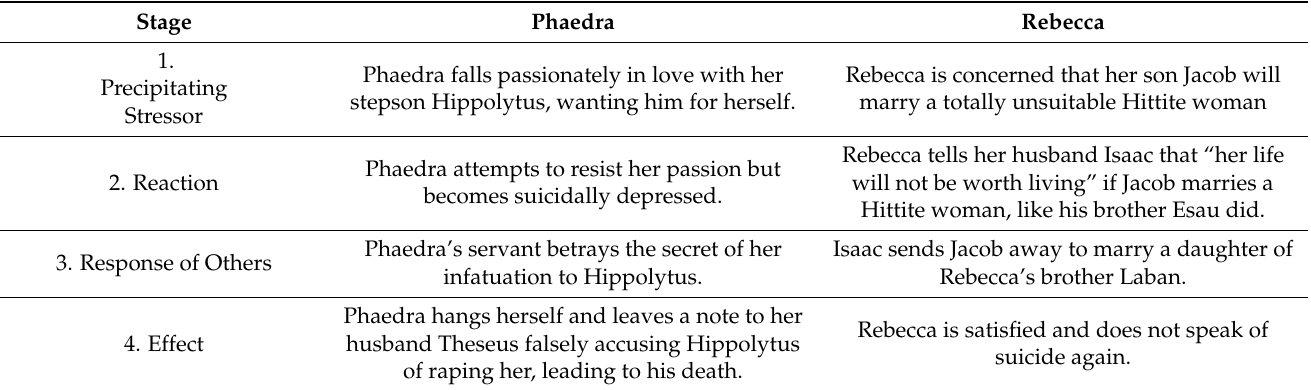
Table 9. Rebecca against